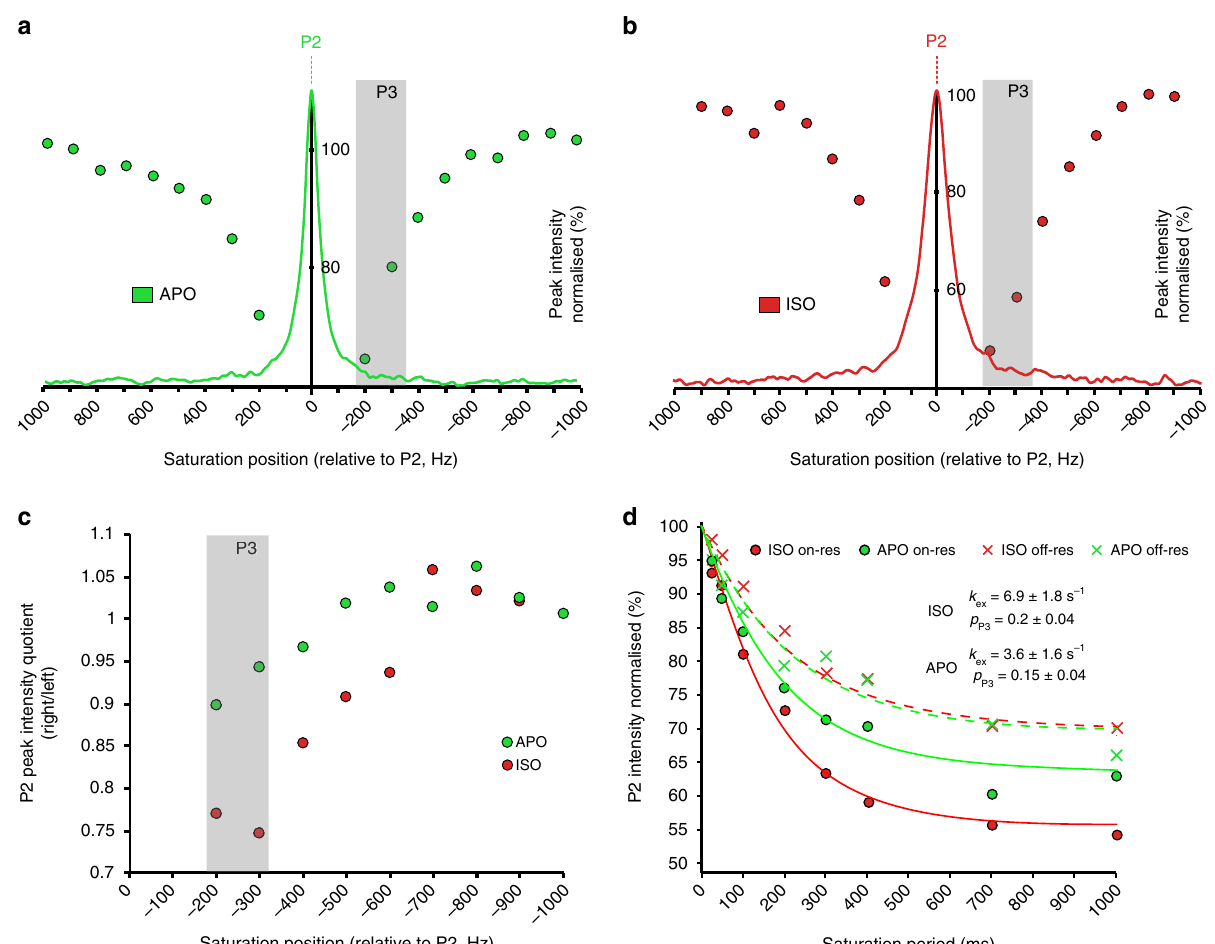
Fig. 3 19 F saturation transfer experiments of TET C344 on TM7. The experiments identify a low populated signal P3 that is in slow exchange with P2. The offset dependence of saturation for ( a ) the apo receptor (green), and ( b ) β 1 AR bound to isoprenaline (red) is probed in increments of 100 Hz. c Peak intensity ratios from pairwise experiments with saturation at symmetrical offsets reveal a maximal response at − 300 Hz relative to the corresponding P2 signal (grey box). The response to saturation increases from the apo form to isoprenaline bound receptor. d Saturation time course for apo receptor (green) and β 1 AR bound to isoprenaline (red) with the irradiation fi eld ( fi eld strength 25 Hz) in the on-resonance experiment (circles) applied at the position of P3, i.e. − 300 Hz from P2. For the off-resonance reference experiment (crosses) saturation was applied at + 300 Hz from P2. Best fi ts for the signal decays are shown by lines with values for k ex and p P3 extracted from simultaneous fi ts indicated for isoprenaline bound receptor as well as the apo